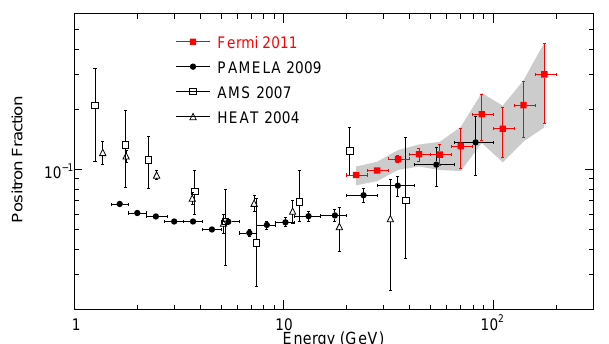
Figure 4: Positron fraction measured by the Fermi LAT and by other experiments [32, 33, 17]. The Fermi statistical uncertainty is shown with error bars and the total (statistical plus systematic uncertainty) is shown as a shaded